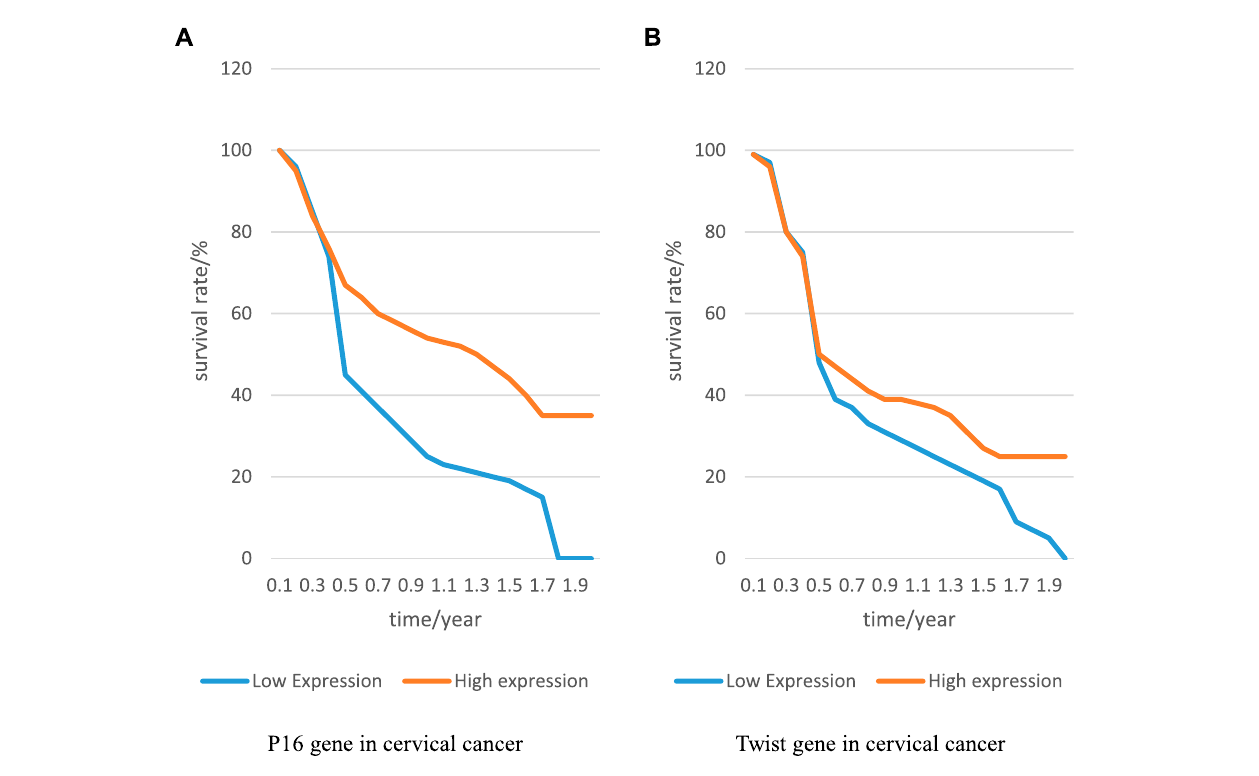
FIGURE 3 p6 and Twist genes and prognosis of cervical cancer. (A) P16 gene in cervical cancer, and (B) Twist gene in cervical